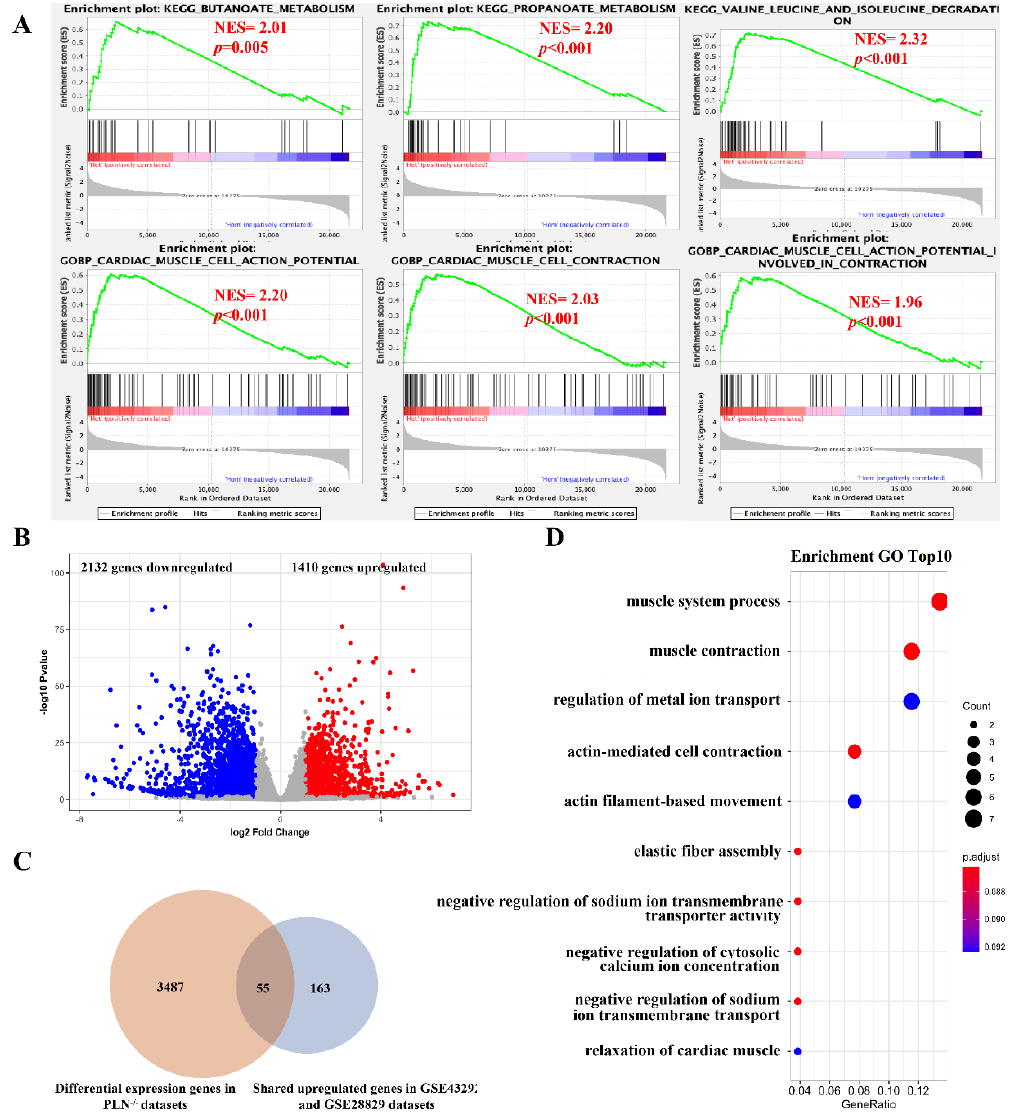
Figure 8. Validation of PLN key gene using gene expression profile of PLN +/ − and PLN − / − mouse heart tissue. ( A ) Gene sets were significantly enriched in PLN +/ − samples based on GSEA analysis. ( B ) Representation of the differentially expressed genes comparing PLN +/ − and PLN − / − mouse heart tissue. ( C ) Venn diagrams showing the common genes between DEGs and commonly downregulated genes in GSE43292 and GSE28829 datasets. ( D ) The bubble diagram of GO-BP enrichment analyses of 55 common genes. Dot sizes represent counts of enriched common genes, and dot colors represent adjusted p -value.